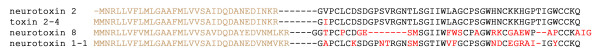
Alignment of polypeptide structures retrieved with motif 1. Mature polypeptides are shown in black; signal peptides and propeptide domains are in light brown. Amino acids that differ from the first sequence of the group are shown in red.